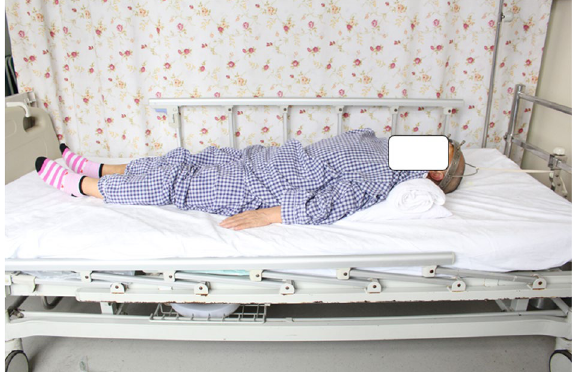
Figure 1. A kyphotic deformity patient with a cervical infection being treated using